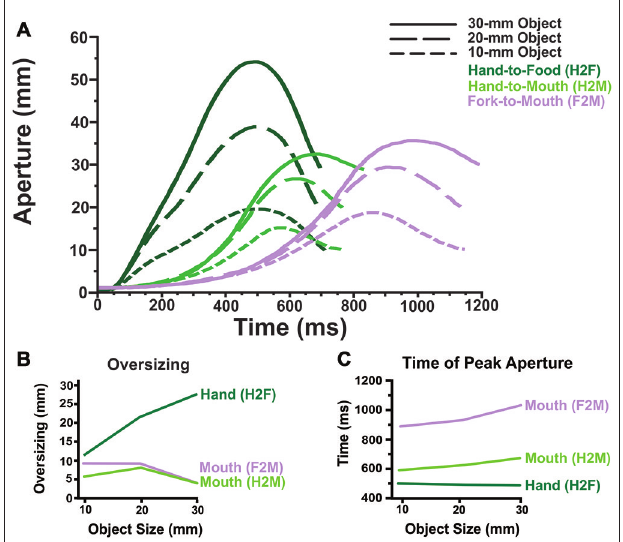
FIGURE 2 | Grip component results. (A) Averaged aperture profiles (as a function of absolute time, in ms) illustrate that Hand-to-Food , Hand-to-Mouth and Fork-to-Mouth reaches display distinctly different grip patterns. (B) The hand oversizes considerably more than does the mouth, regardless of whether or not a fork was used to transport the food item. Moreover, oversizing scales with object size for the hand but not the mouth. (C) The mouth reaches peak aperture later than does the hand, particularly if a fork was used to transport the